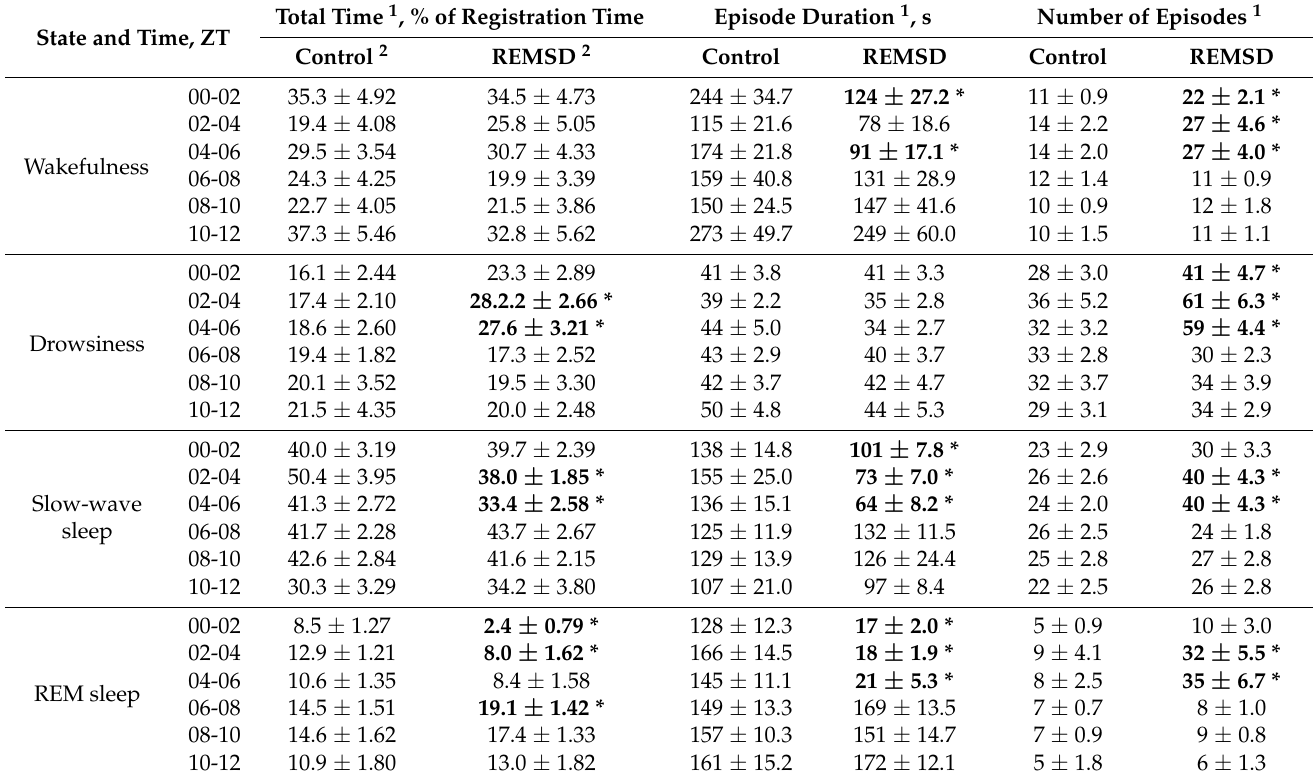
Table 1. Temporal characteristics of the sleep–wake cycle during and after short-term selective REM sleep deprivation (REMSD) in